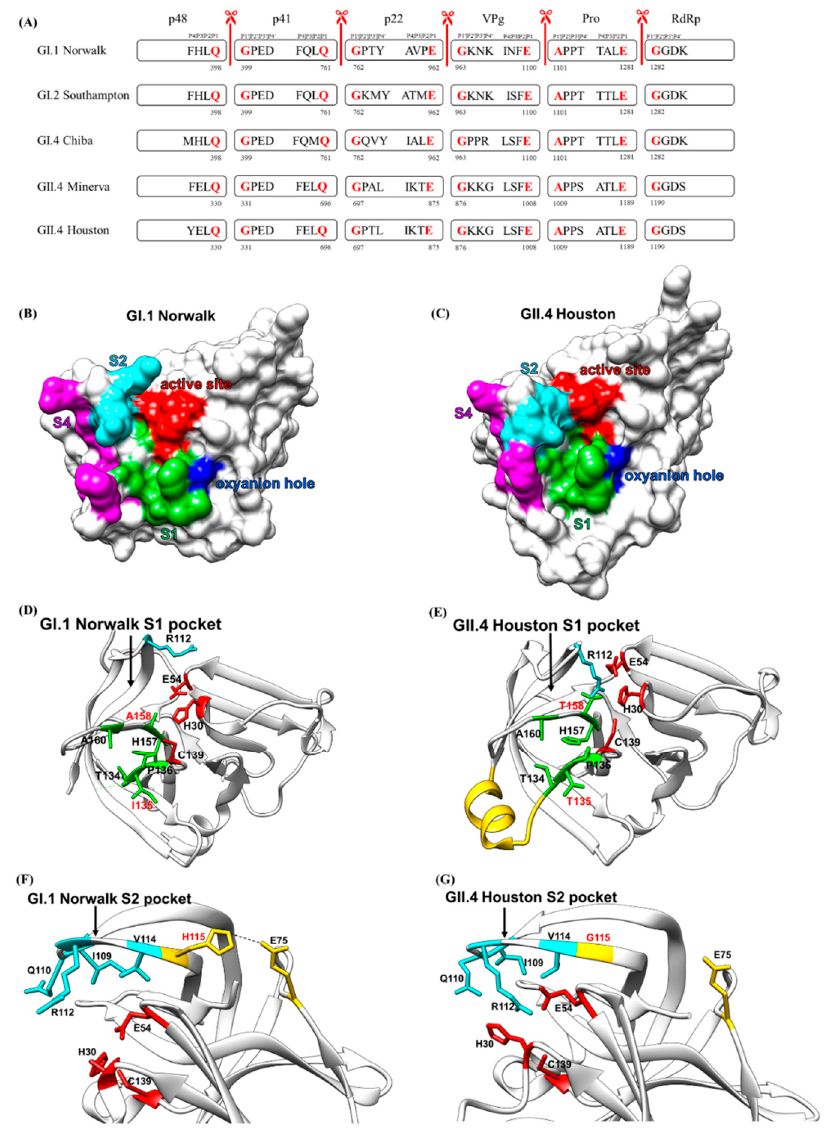
Figure 4. Protease cleavage sites and the substrate-binding pockets. ( A ) Cleavage sites of five HuNoV proteases. Each box indicating a non-structural protein contains the P4–P1 residues in its right side and the P1 ′ –P4 ′ residues in its left side. P1 and P1 ′ residues are colored in red. ( B ) Surface representation of the substrate-binding pockets of Norwalk virus and ( C ) of Houston virus. ( D – G ) Structural comparison of Norwalk (PDB ID: 2FYQ) and HOV (PDB ID: 6NIR) proteases. ( D , E ) The residues mediating the binding specificity of the S1 pocket and the active site residues are colored in green and red, respectively. The structural differences between Norwalk and HOV are colored in cyan and yellow. ( F , G ) The residues mediating the binding specificity of the S2 pocket and the active site residues are colored in cyan and red, respectively. The structural differences of these proteases are colored in yellow.